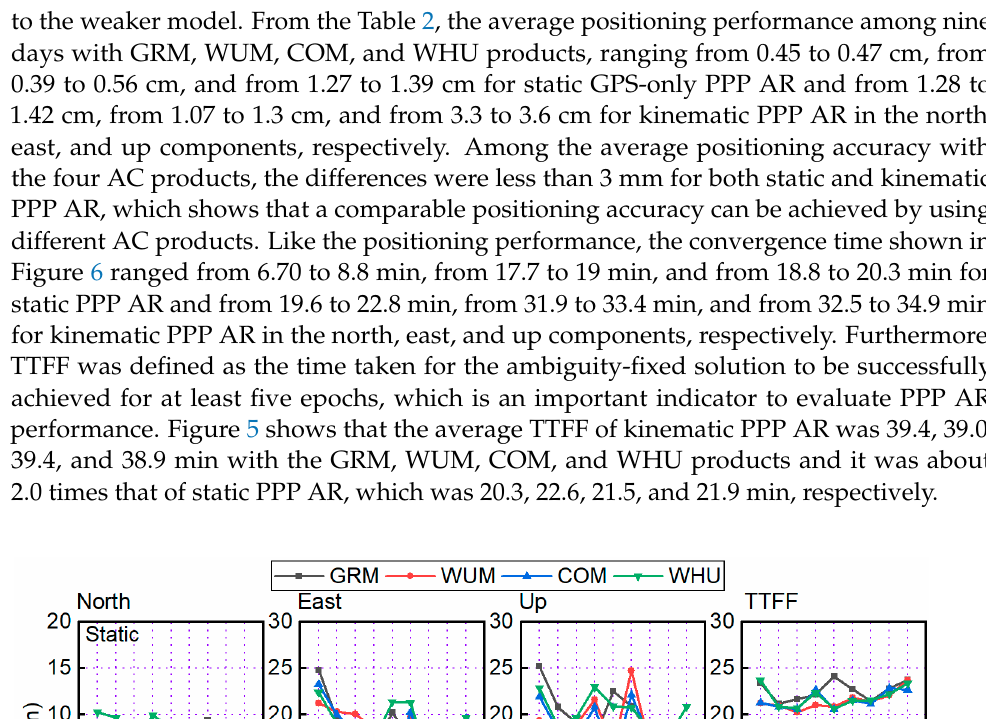
Figure 5. Average positioning errors series among nine days of static (top) and kinematic (bottom) GPS-only PPP AR in north, east, up, and 3D components with GRM, WUM, COM, and WHU products.